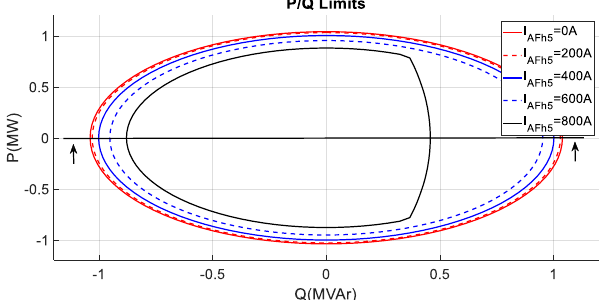
Figure 13. Maximum active and reactive power injection capability for different injected 5th harmonic current values (DHC) at nominal voltage (400 V).